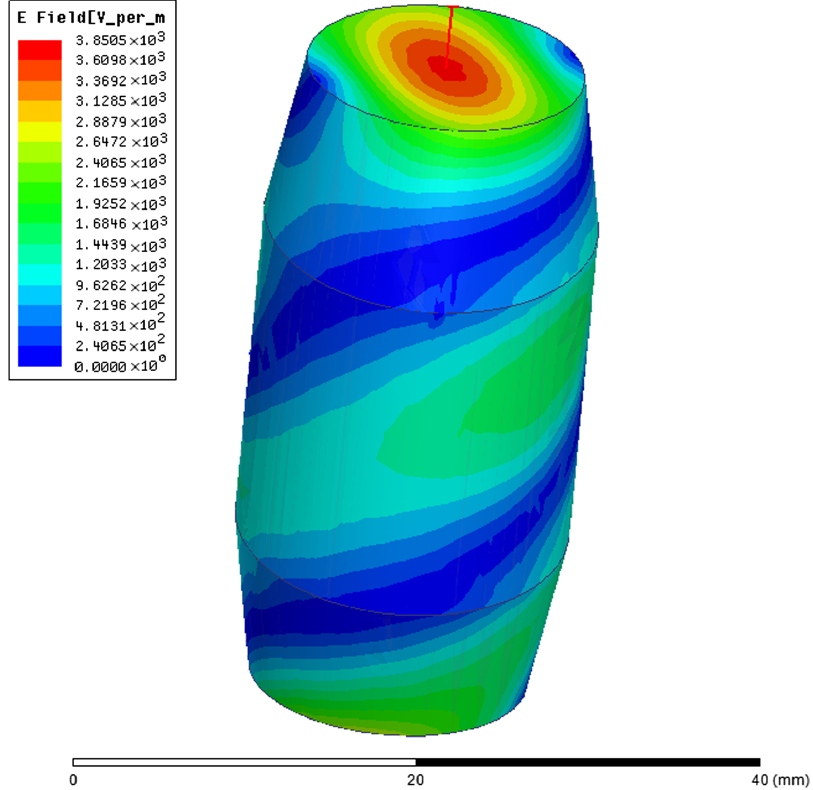
FIG. 8. Ellipse converter and E field pattern on the surface. The power from input port is 1 W for each polarization, and two polarizations are 90 degree apart. Peak E field is smaller than the peak E field in the OMT in